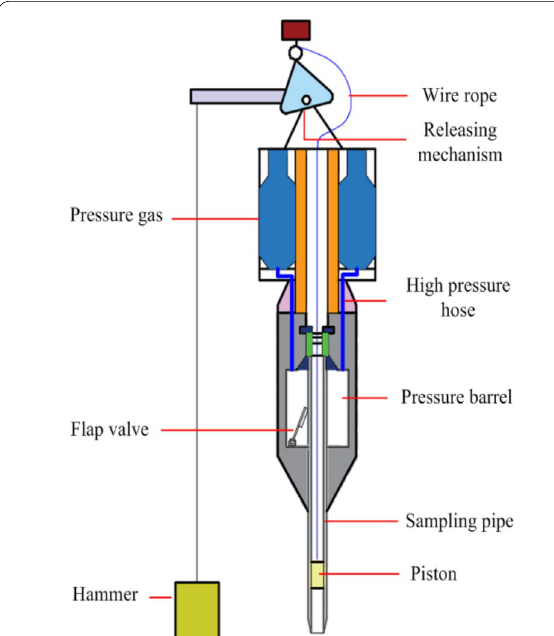
Figure 8 Schematic of the pressure and insulation corer (PIC)